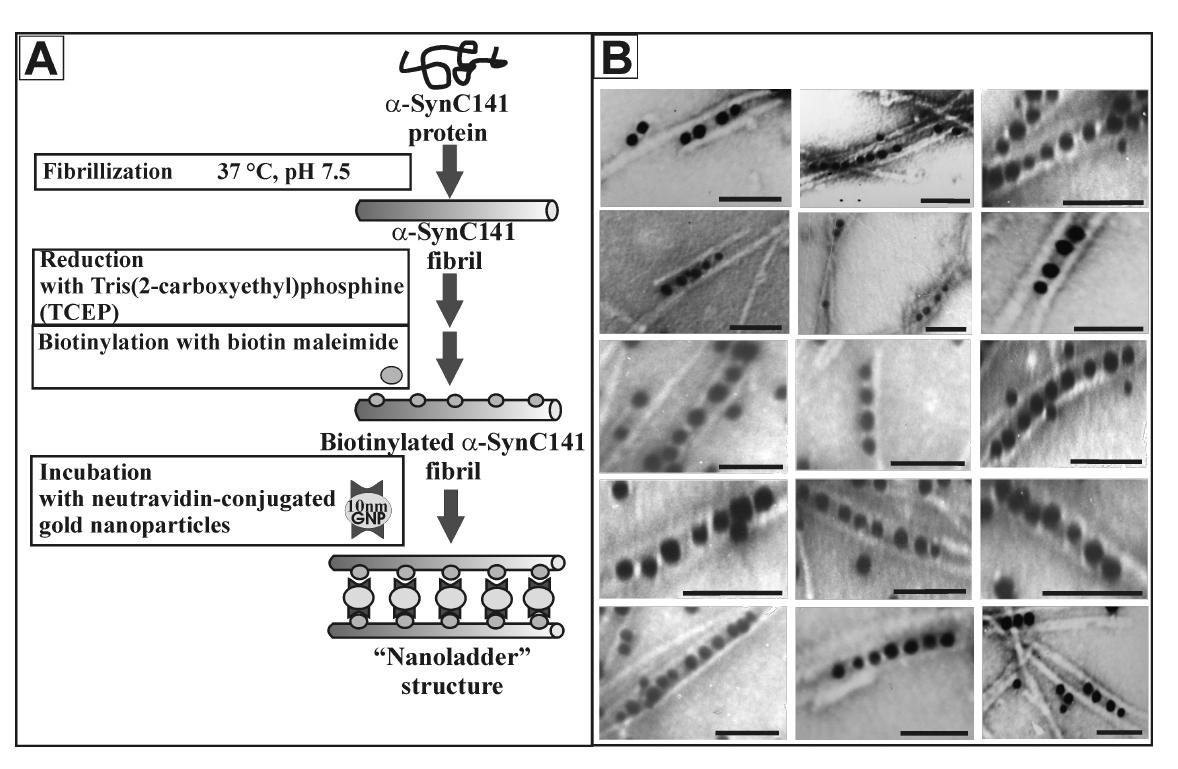
Figure 4: Schematic illustration of the formation of the hybrid nanostructure (nanoladder) (A). TEM images of the ladder-like nanostructures composed of two biotinylated α -SynC141 fibrils coupled with neutravidin-conjugated gold nanoparticles (B). The scale bars are 50